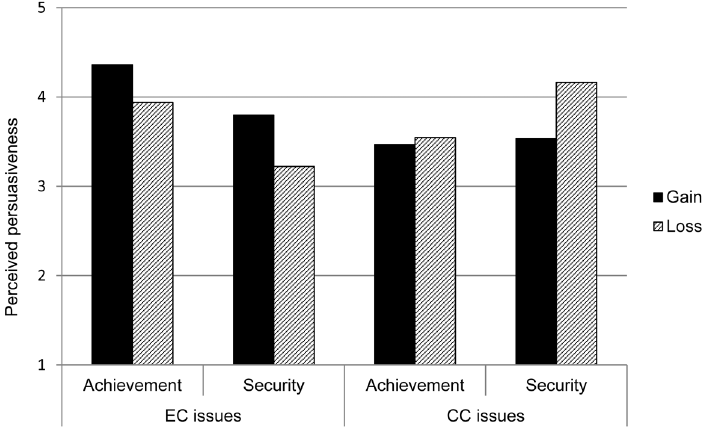
Figure 2. Perceived persuasiveness as a function of type of issue, outcome focus and type of benefit (Study 2).